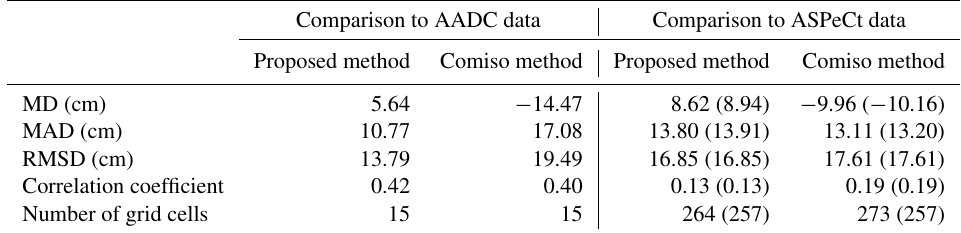
Table 5. The comparisons between the snow depth estimates from the proposed method and Comiso method and in situ measurements from AADC and ASPeCt. MD: mean difference; MAD: mean absolute difference. The results of the evaluation by comparing to the ASPeCt data in the overlapped regions where both valid snow depth estimates from the proposed method and Comiso method can be found are provided in brackets.